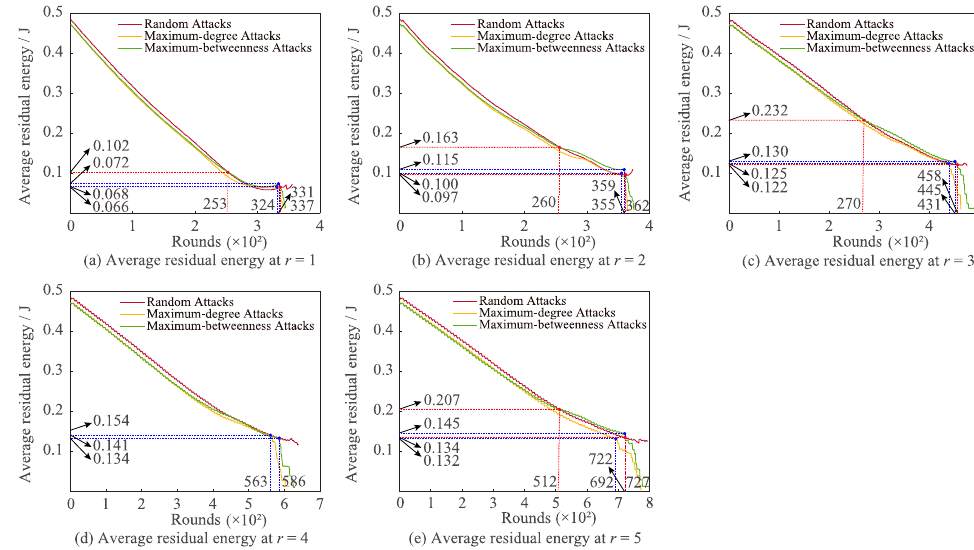
Figure 8. Impacts of altering r on average residual energy for various attacks.